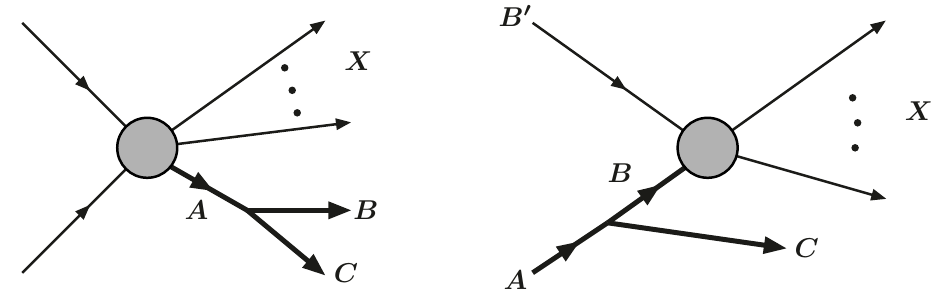
Figure 1. Schematic processes involving a collinear splitting A (left) or initial state